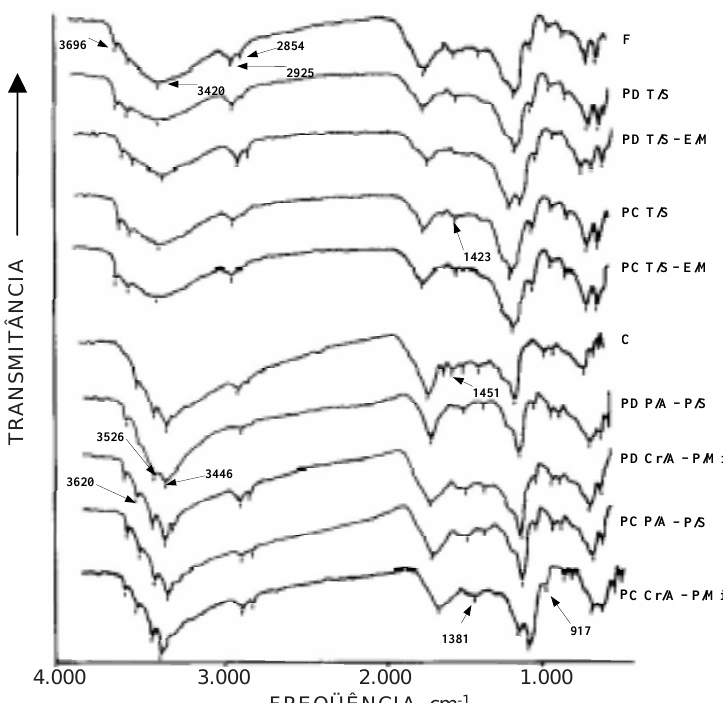
Figura 1. Espectros de infravermelho da fração leve-livre. F: Latossolo sob floresta em Passo Fundo; PD: plantio direto; T: trigo, S: soja; E: ervilhaca; M: milho; PC: preparo convencional; C: Latossolo sob